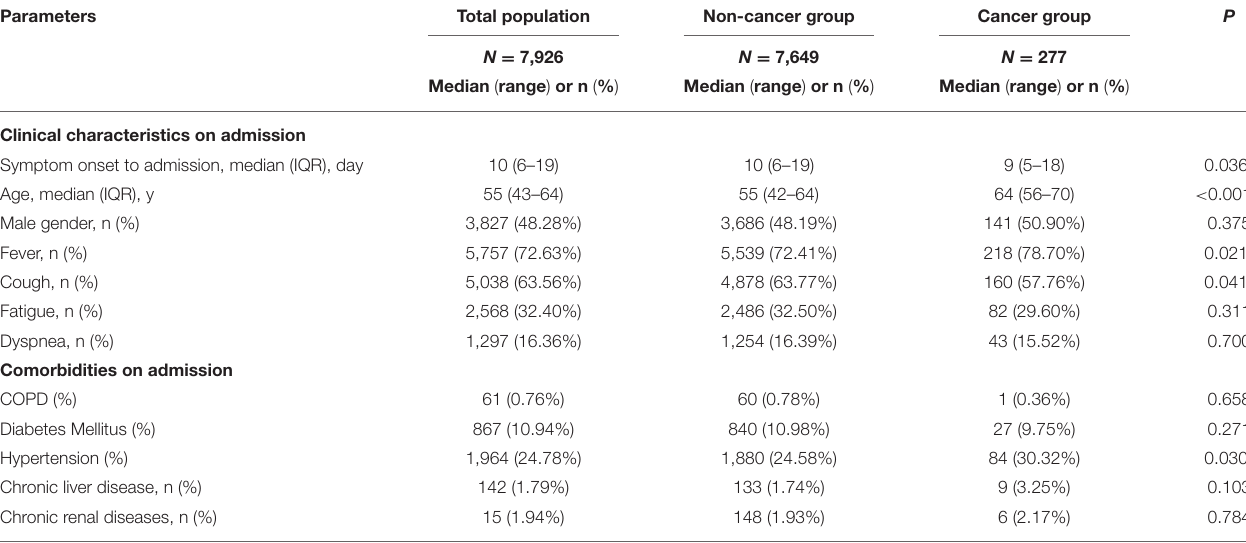
TABLE 1 | Clinical characteristics and Comorbidities of patients with COVID-19 in Non-cancer group and cancer group on admission. Parameters Total